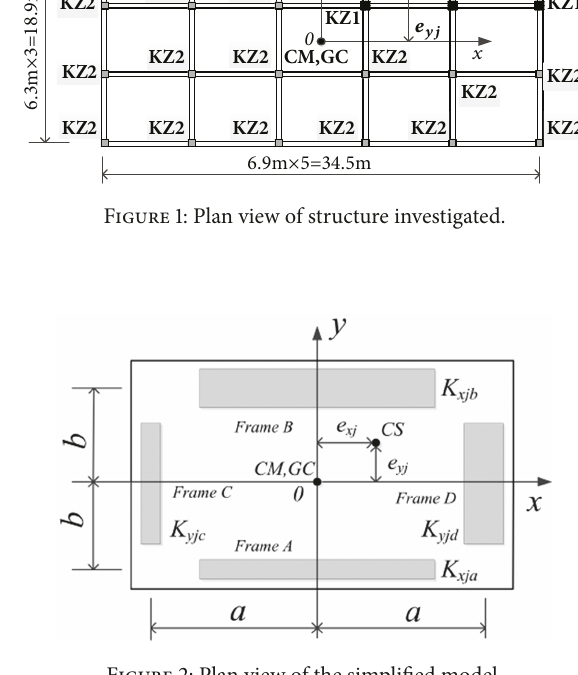
Figure 2: Plan view of the simplified